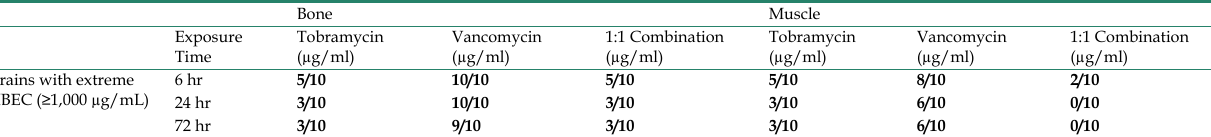
Table 2. Strains with extreme minimum biofilm eradication concentration (MBEC) for musculoskeletal biofilms on bone and muscle